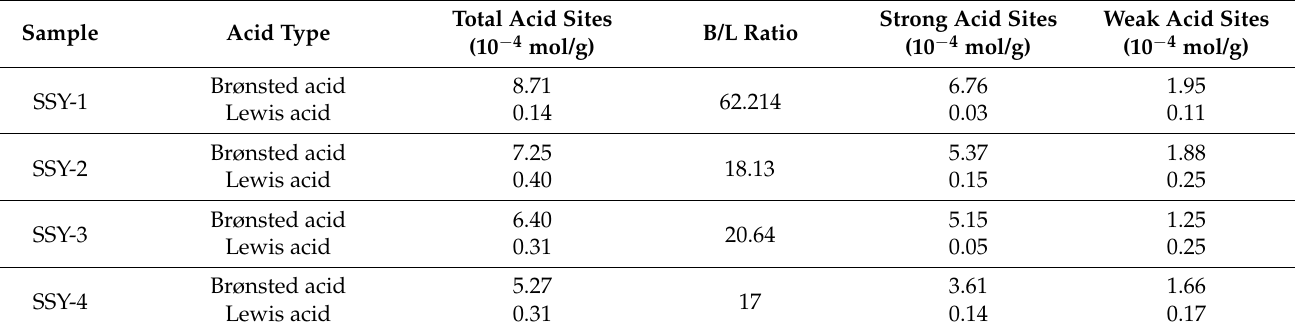
Table 3. Acidic properties of ammonium hexafluorosilicate modified